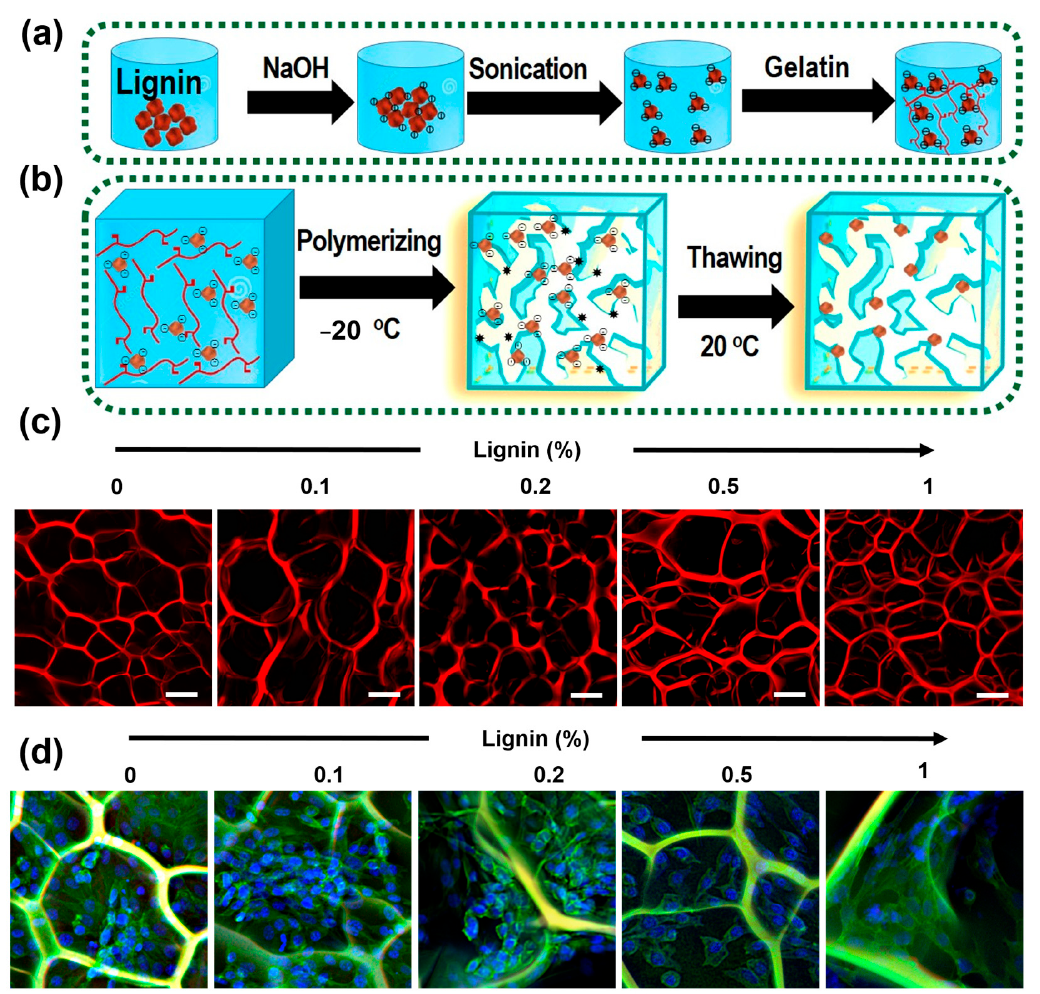
Figure 3. Syringe-injectable antioxidant and antimicrobial lignin-co-gelatin cryogels for biomedical applications. ( a ) Schematic illustration of the lignin-gelatin solution preparation by alkali-assisted ultrasonication method. ( b ) Schematic representation of lignin-co-gelatin cryogel fabrication by freeze-thawing method. ( c ) Zone inhibition diameters of the composite cryogels with different concentration of lignin against E. coli and S. aureus. ( c , d ) Confocal microscopy images of the composite cryogels with different concentration of lignin before ( c ) and 72 h after ( d ) culturing NIH/3T3 fibroblast cells (adapted from ref [96] with permission).